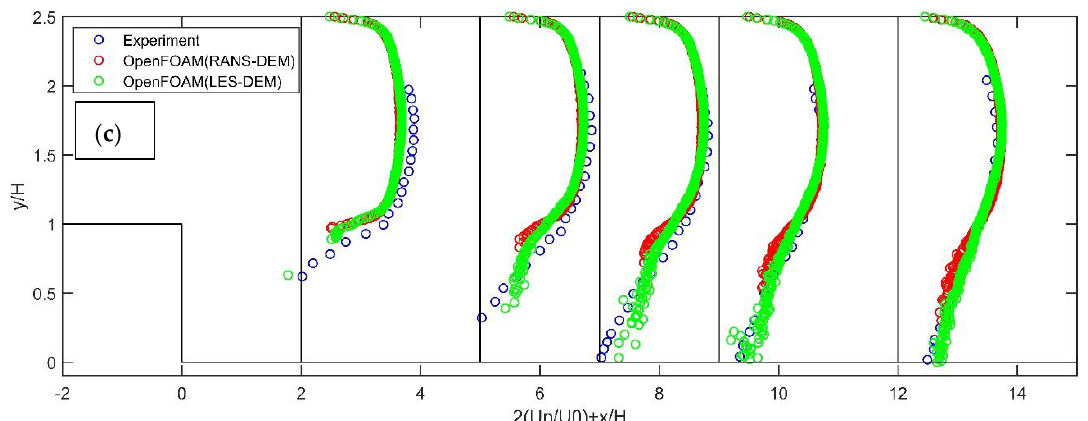
Figure 8. Comparisons of experimental and OpenFOAM simulated average streamwise particle velocity profiles at the measurement locations for two-way coupling and 10% mass loading of copper particles under RANS-DEM and LES-DEM frameworks. ( a ) Particle injection velocity as (10.5, 0, 0) m/s, ( b ) a particle injection velocity same as that of the fluid velocity profile at the inlet, ( c ) particle injection velocity as (0, 0, 0) m/s.